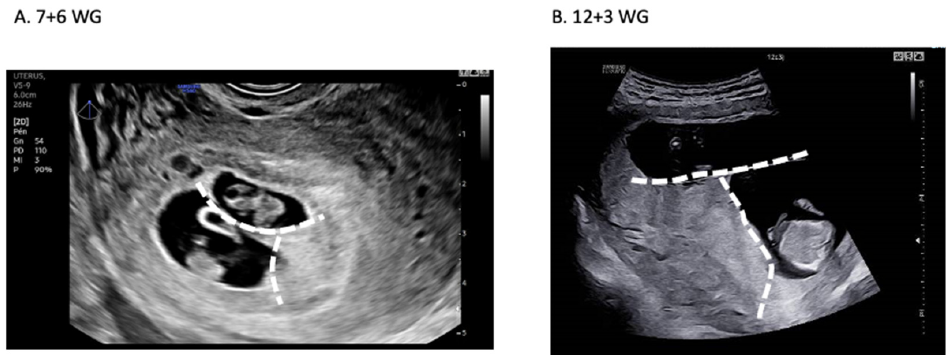
Figure 3. Ultrasound assessment of dichorionic diamniotic twin pregnancy. ( A ) First ultrasound scan at 7+6 WG showing two amniotic gestational sacs with a “lambda” sign referring to the triangular appearance of the chorion (dotted white line). ( B ) Confirmation of the dichorionic diamniotic twin pregnancy at 12+3 WG.